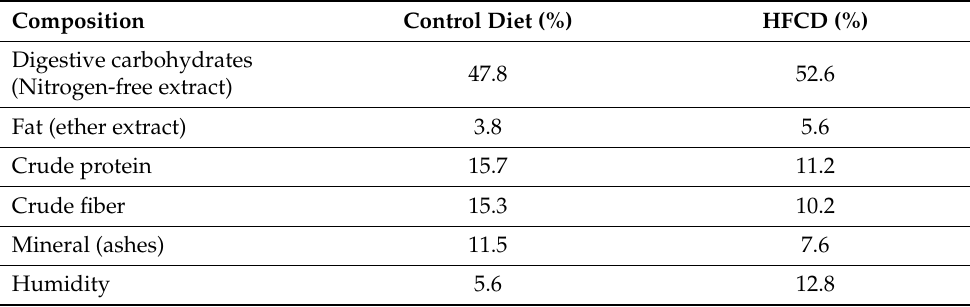
Table 2. Nutrient composition of the control diet and HFCD